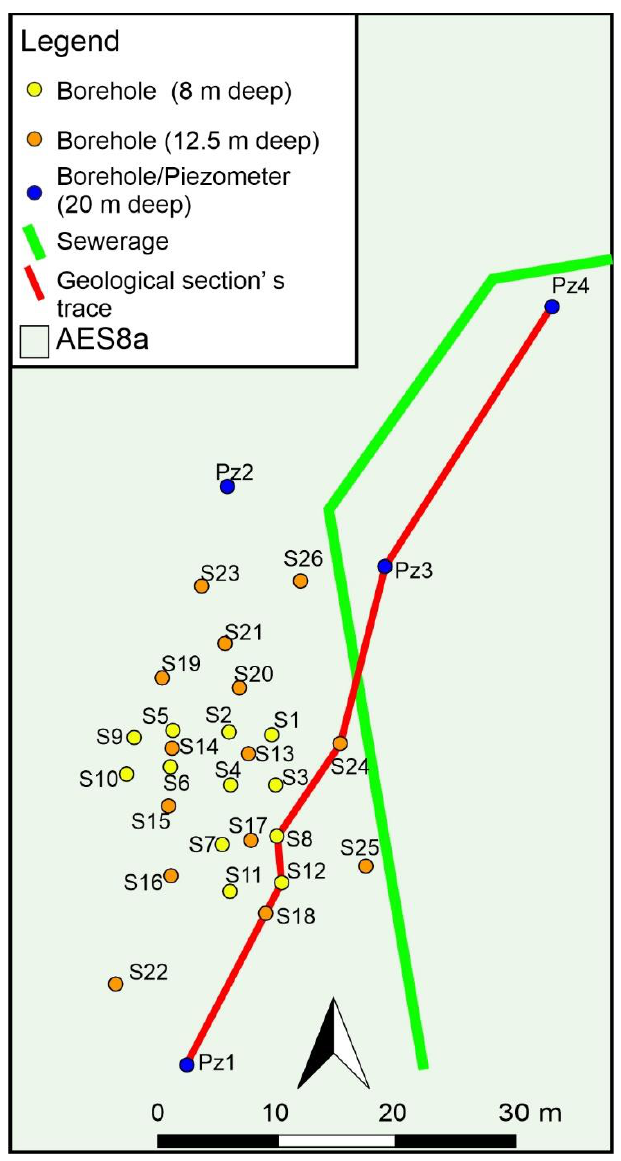
Figure 3. Location of boreholes and piezometers drilled at the test site (the red segment is related to Figure 4).